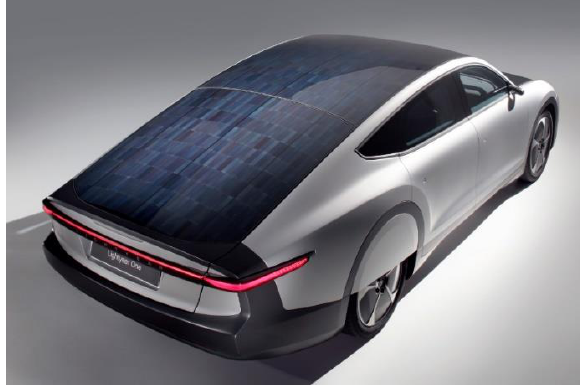
Fig. 11. Lightyear One – Solar Electric Powered Car [45]